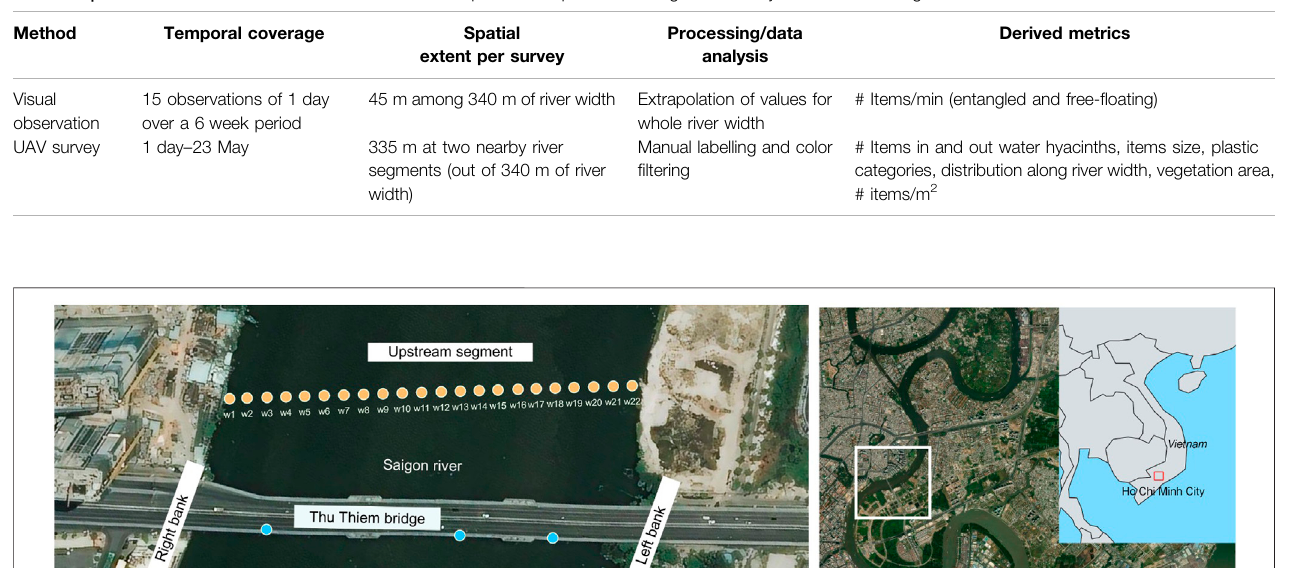
TABLE 1 | Overview of methods used to characterize macroplastic transport and storage in water hyacinths for the Saigon river.